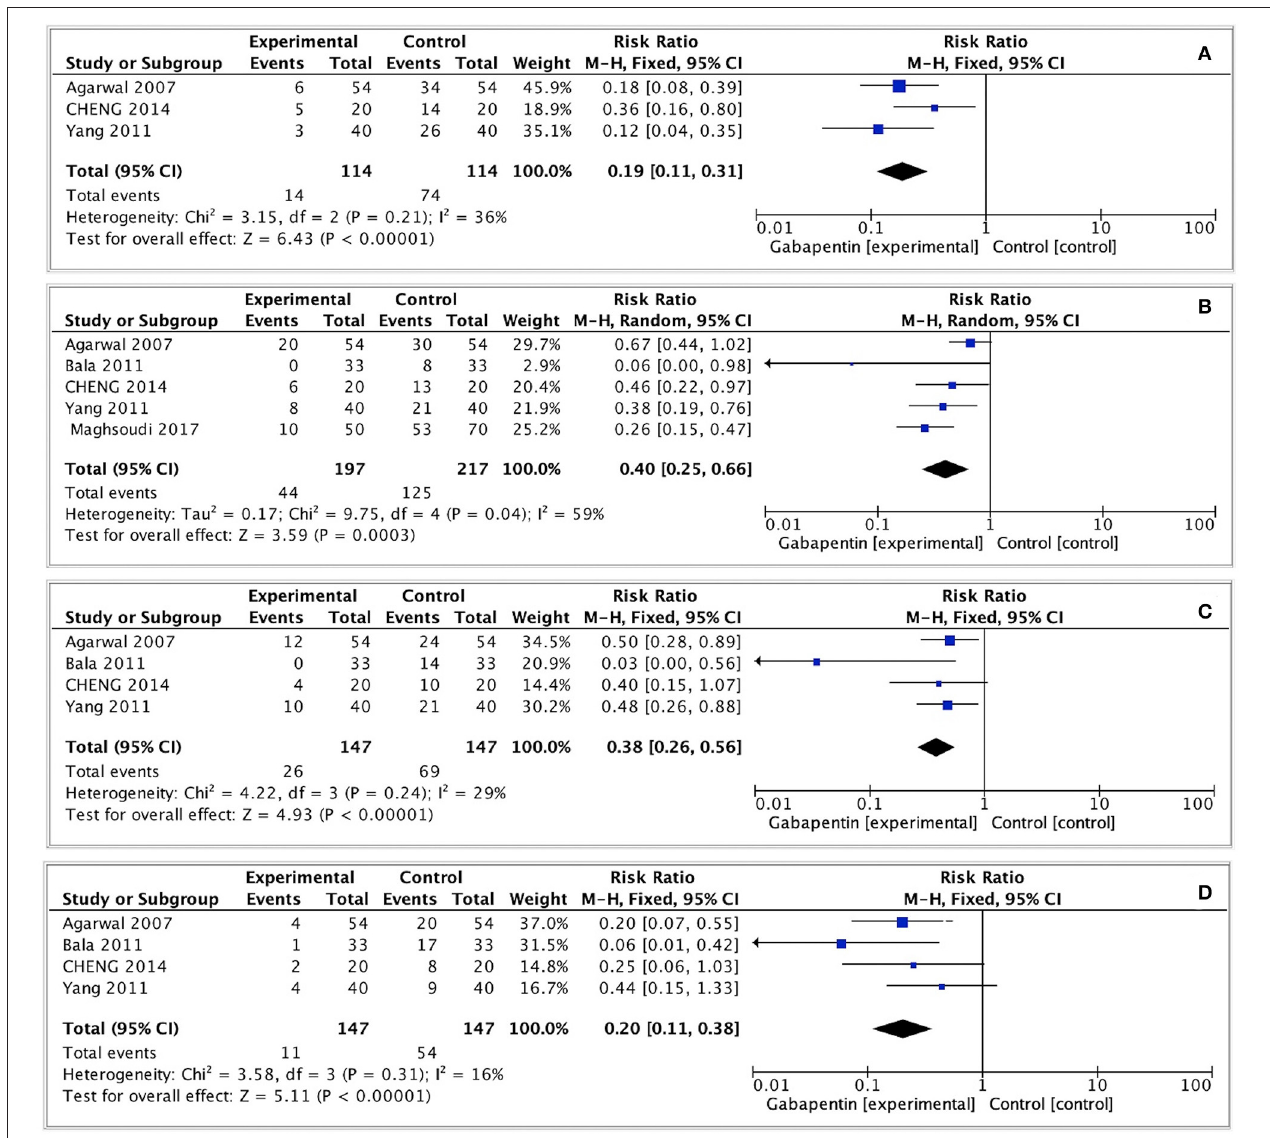
FIGURE 3 | Forest plot of moderate-to-severe postoperative CRBD. (A) Moderate-to-severe postoperative CRBD at 0h after surgery; (B) Moderate-to-severe postoperative CRBD at 1h after surgery; (C) Moderate-to-severe postoperative CRBD at 2h after surgery; (D) Moderate-to-severe postoperative CRBD at 6h after